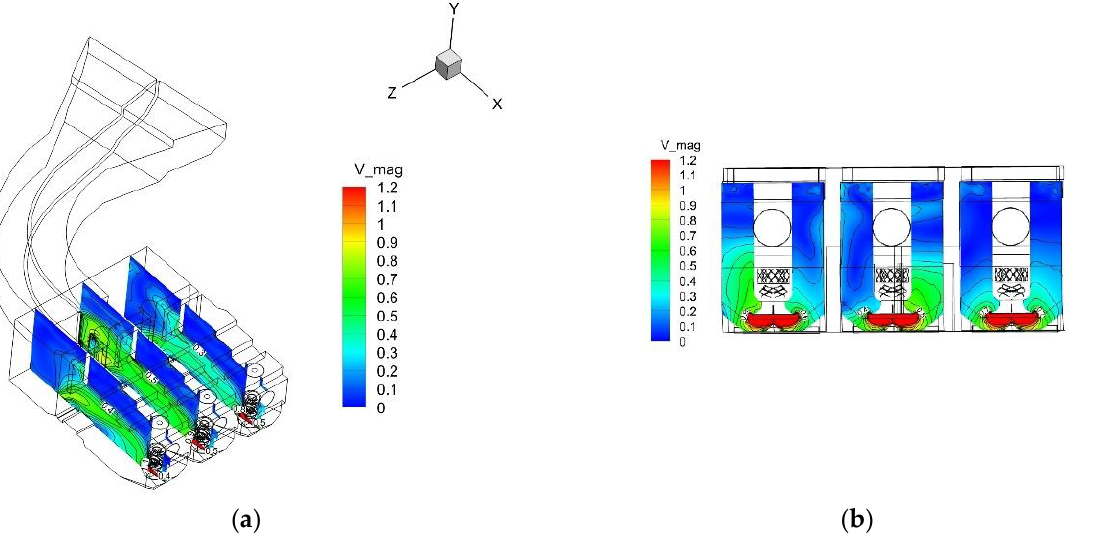
Figure 13. Plan 5 Isogram of velocity. ( a ) Center section of pump body along flow direction. ( b ) Center section of pump body in vertical flow direction.